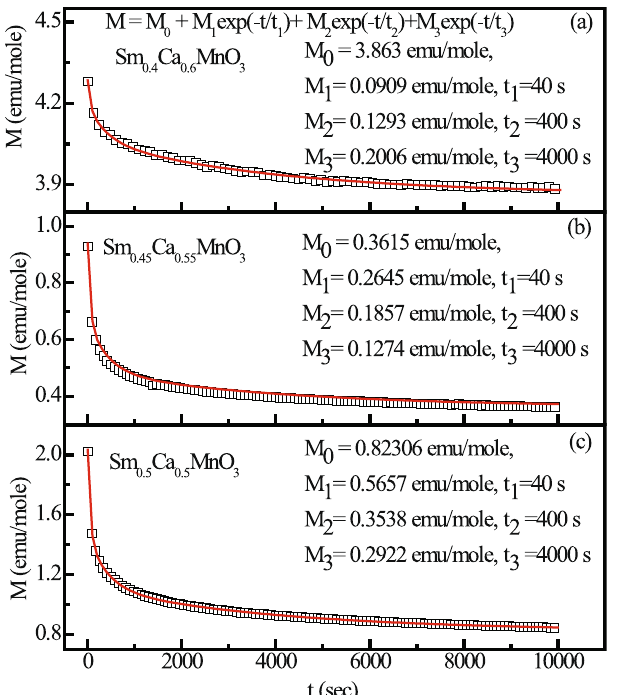
Figure 5. M as a function of time t for bulk Sm 1 − x Ca x MnO 3 (x = 0.5, 0.55 and 0.6) compounds at 5 K. Solid line is a fit to M =